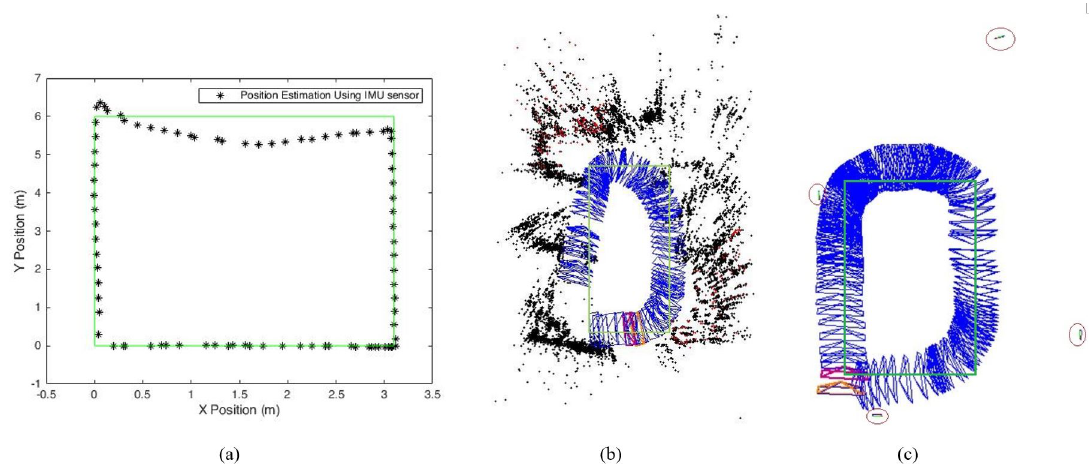
Figure 4. Indoor localization. ( a ) IMU-based localization. ( b ) ORB-SLAM localization. ( c ) UcoSLAM localization.